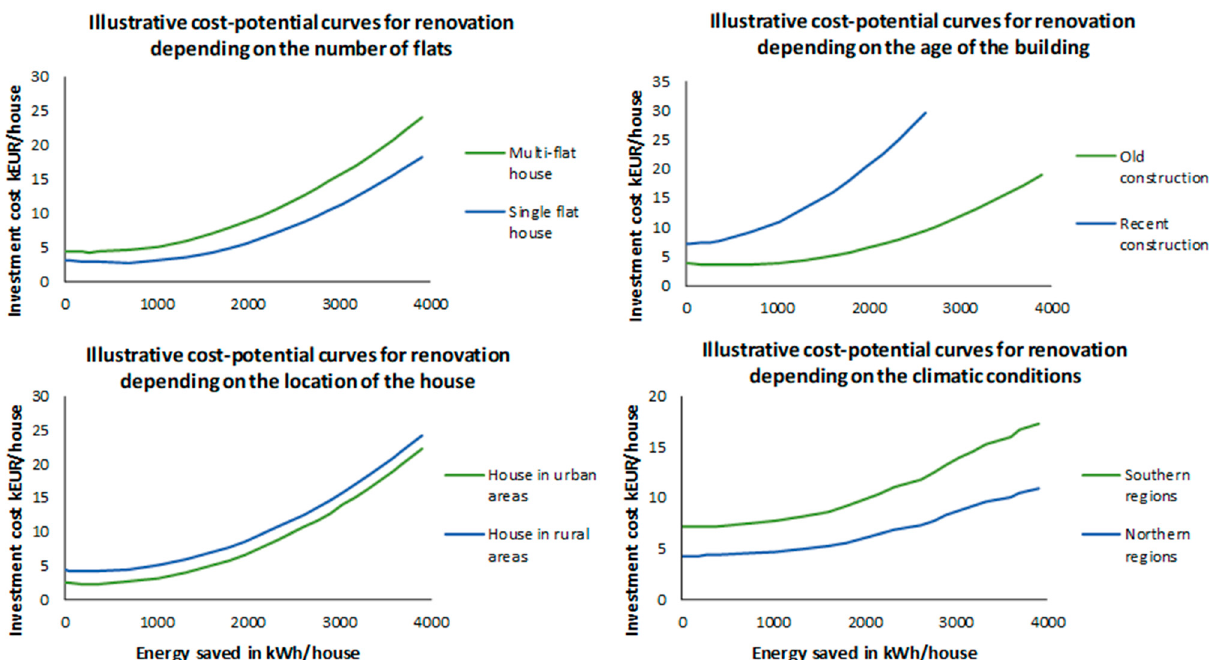
Figure 2. Cost–potential curves relating unit investment cost of house renovation with saved energy potential.